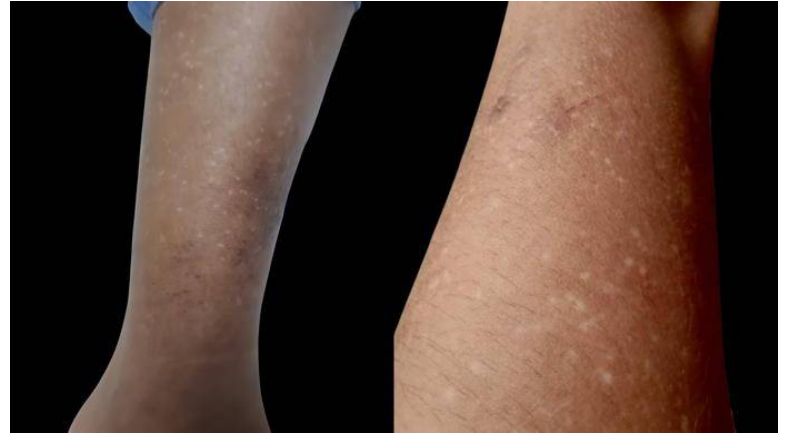
Figure 1. Hyperpigmented and hypopigmented to depigmented macules on the legs.